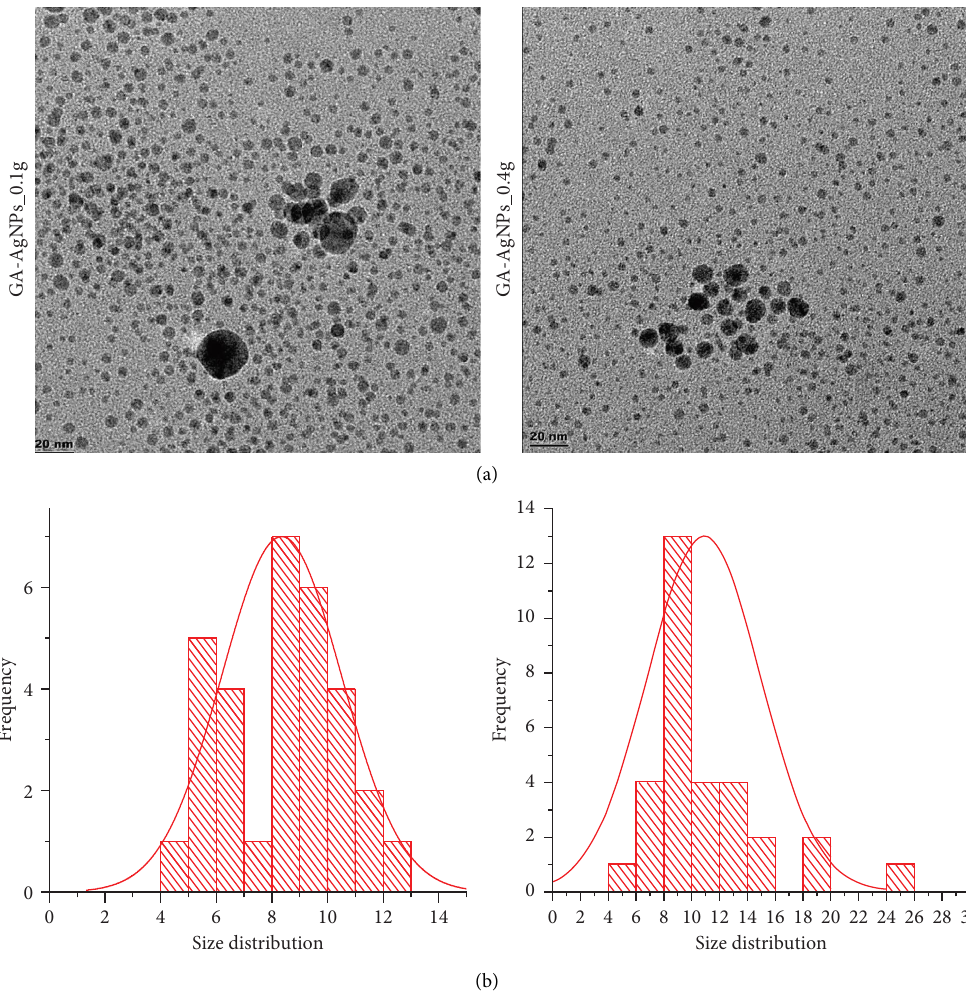
Figure 3: (a) HRTEM micrographs and (b) core size distribution of the